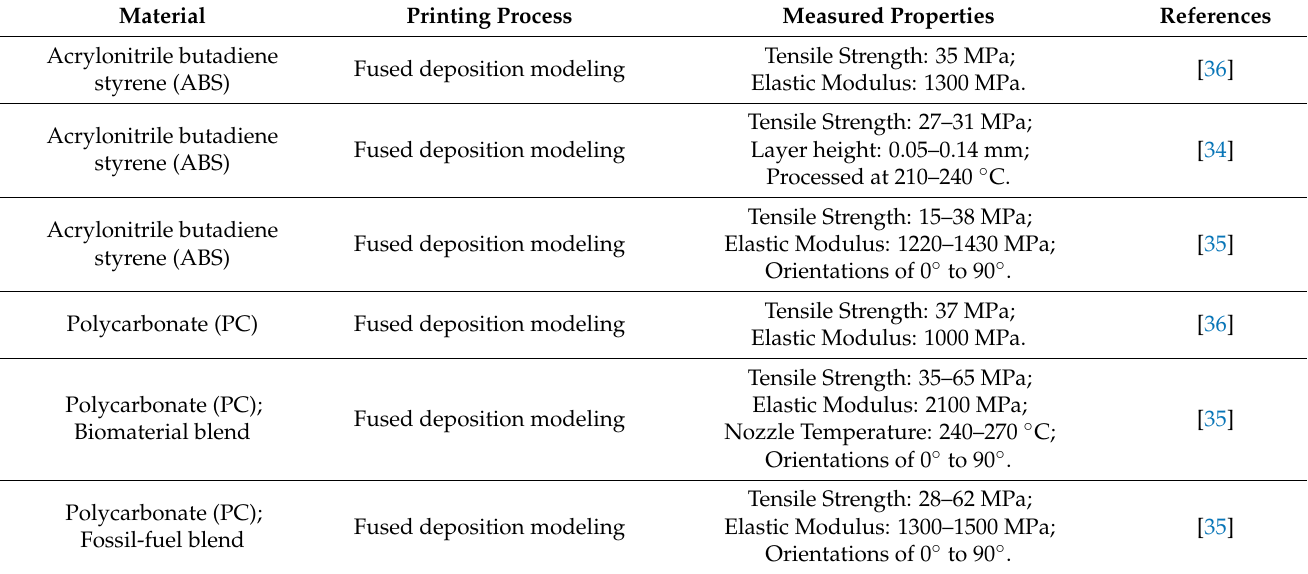
Table 1. Measured 3D-printed part properties organized by material and printing process. Further details included to provide relevant